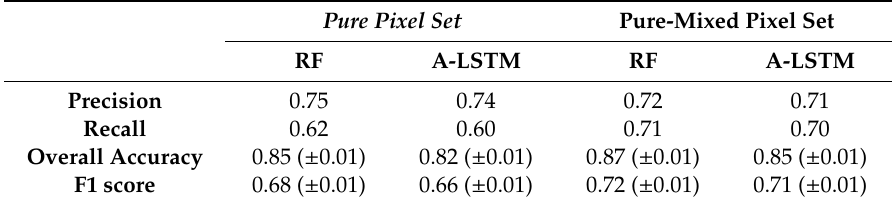
Table 4. Precision, recall, overall accuracy and F1 scores for the two models trained on di ff erent datasets.